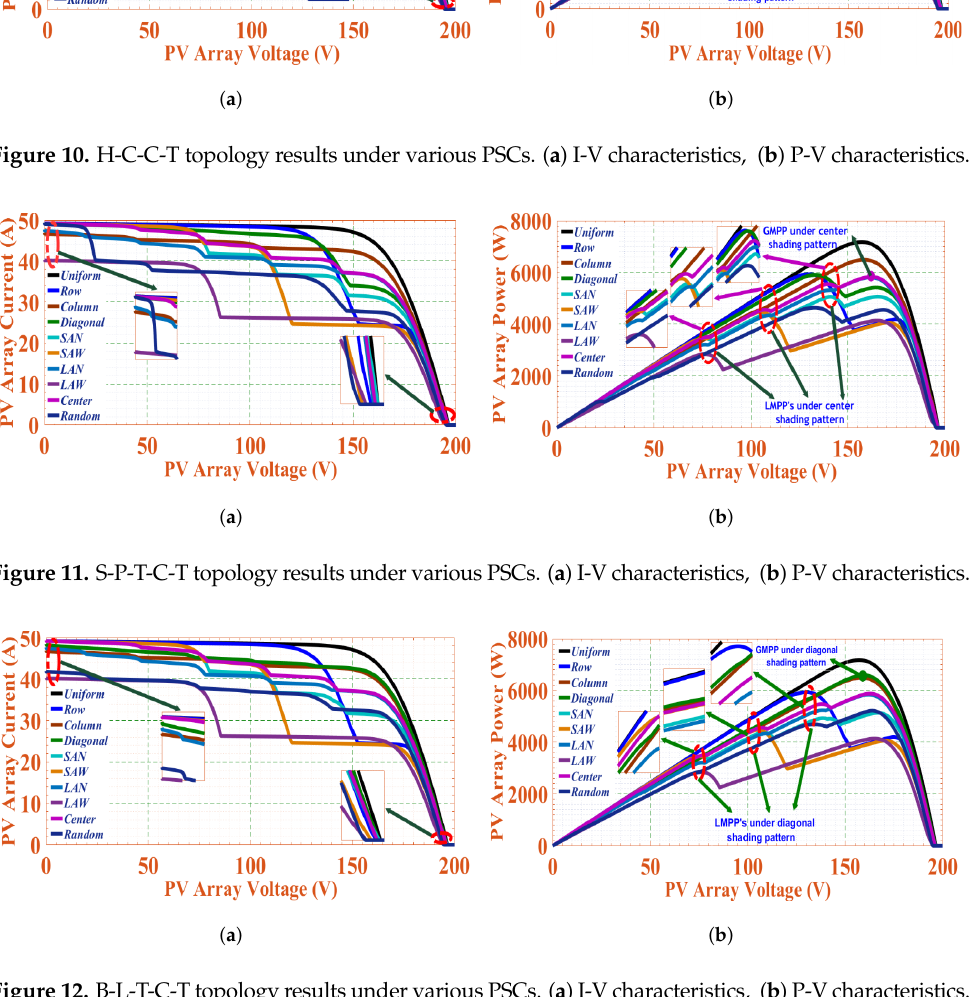
Figure 12. B-L-T-C-T topology results under various PSCs. ( a ) I-V characteristics, ( b ) P-V